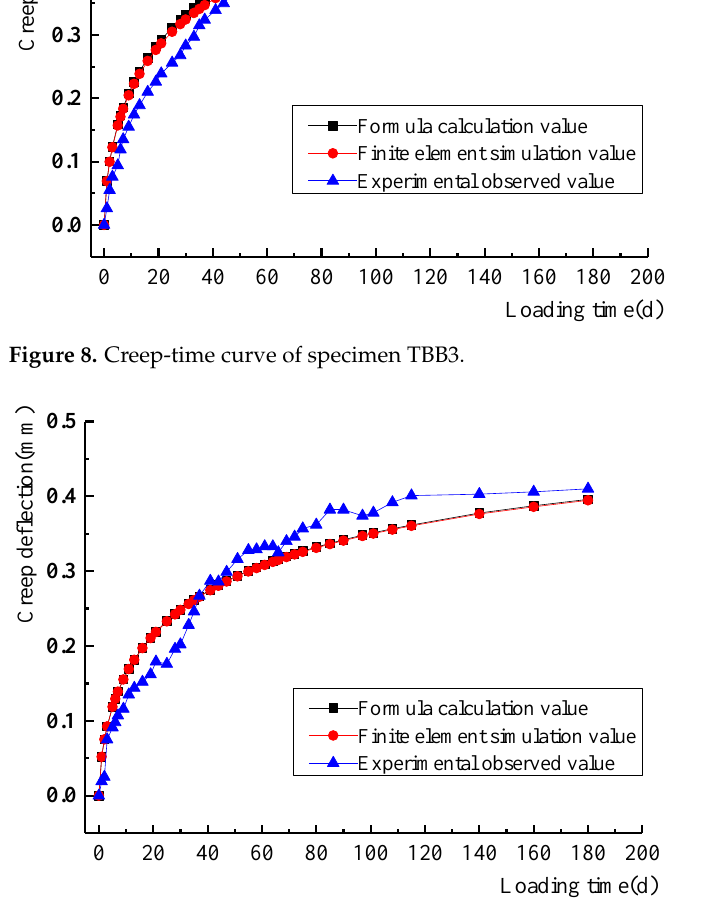
Figure 9. Creep-time curve of specimen TBB4.